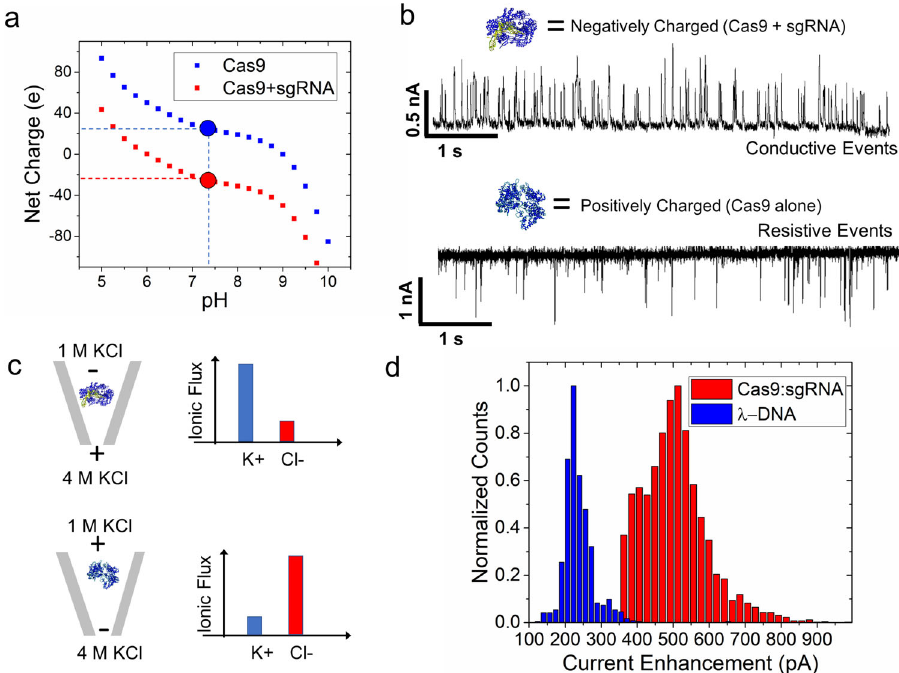
Fig. 5 Event characteristics for Cas9d10a and the Cas9d10a + sgRNA complex under asymmetric salt conditions (1 M inside pore/4 M KCl outside pore). a Graph of net charge based on calculations of amino acid composition of Cas9d10a alone and Cas9d10a-sgRNA at various pH values. The black dotted line represents the pH value of our working conditions (7.4), and the red and blue circles are the corresponding charges of Cas9d10a + sgRNA and Cas9d10a alone, respectively. b Current trace of Cas9d10a with and without sgRNA in asymmetric salt conditions (1 M KCl inside and 4 M KCl outside). Events were resistive when Cas9d10a was inside the nanopipette, and a positive voltage is applied inside the nanopipette. Cas9d10a was pre-incubated before diluting in 1 M KCl where the Cas9d10a and sgRNA were in an equimolar ratio (1:1). Events were conductive when Cas9d10a + sgRNA was inside the nanopipette and a negative voltage was applied inside the nanopipette. c Schematic of set-up (left) and fl uxes of K + and Cl − under both conditions. Top condition includes the negatively charged complex of Cas9d10a and sgRNA. The bottom condition contains the positively charged Cas9d10a molecule alone. Both have 1 M KCl + analyte within the nanopipette and 4 M KCl within the electrolyte bath solution. d Current enhancement observed for both DNA and protein using similar sized pores (36 nS for Cas9:sgRNA and 33 nS for λ -DNA) and the same voltage bias of − 500 mV. An asymmetric salt condition was used on both experiments (1 M/4 M KCl) and voltage was applied inside the nanopipette; driving negative DNA and protein – RNA complexes out of the